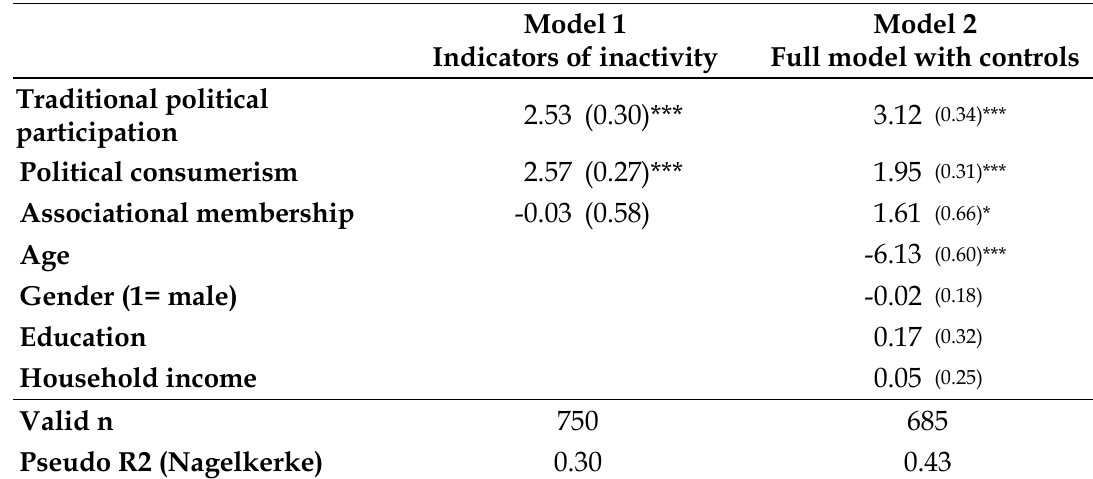
Table 4: Internet activism and